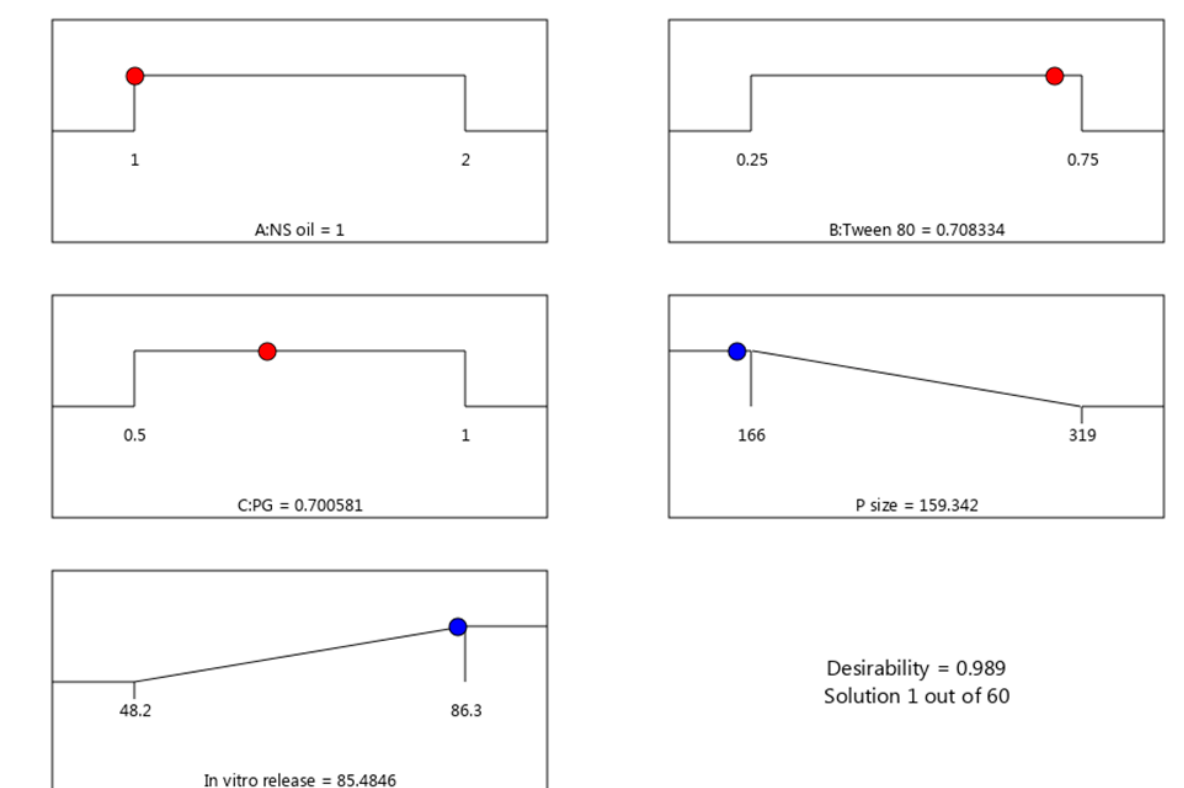
Figure 5. Optimization ramps for the independent variables ( A – C ) with the predicted values of responses (particle size and in vitro release) showing the desirability value.